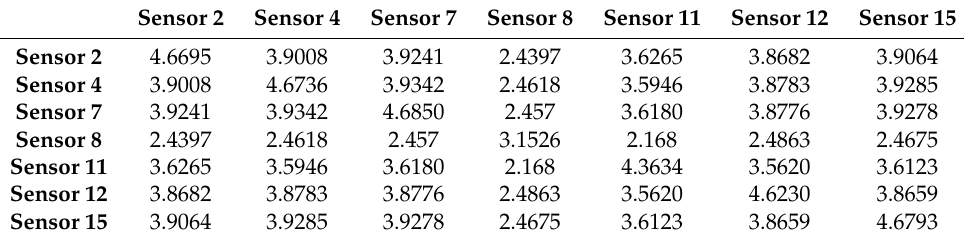
Table 11. Mutual information values among sensors selected by observing strategy for data set 4.